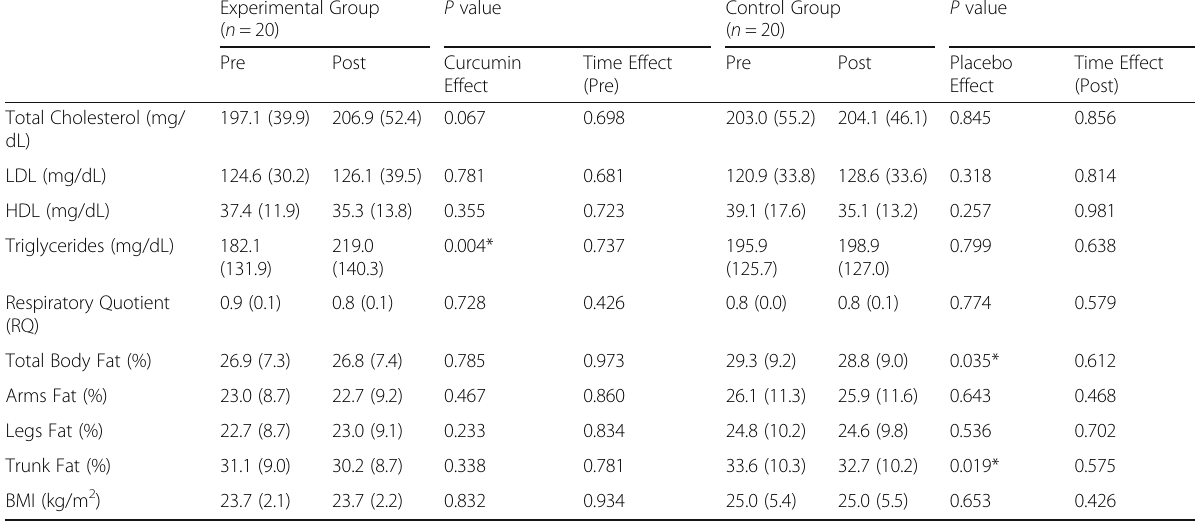
Table 3 Effect of curcumin supplementation on lipid profile, respiratory quotient, and body composition in people living with HIV/ AIDS